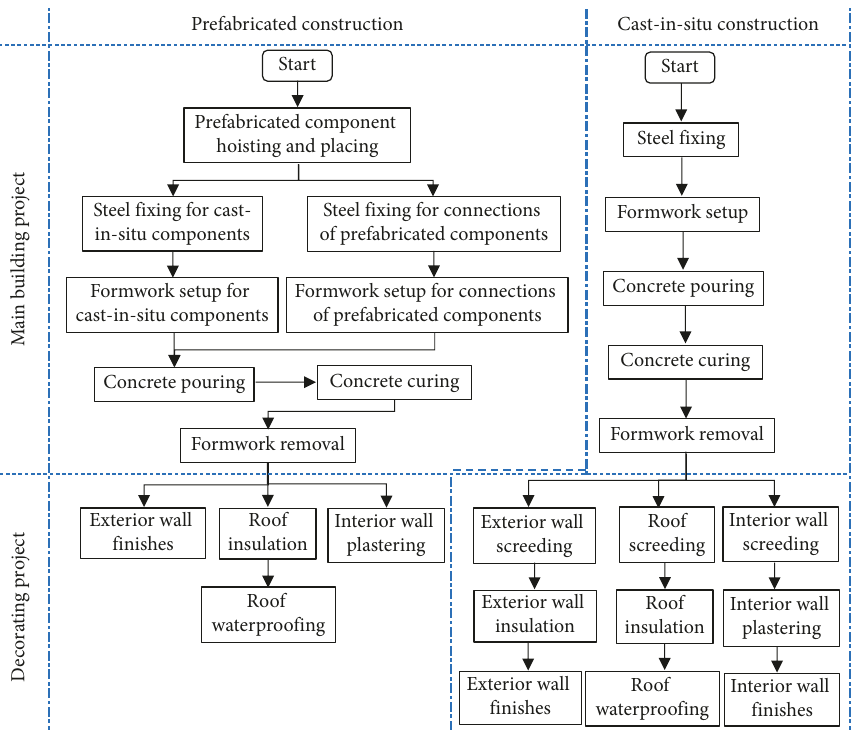
Figure 6: Simulated prefabricated and cast-in-situ construction processes developed by the researchers, referring to the construction code